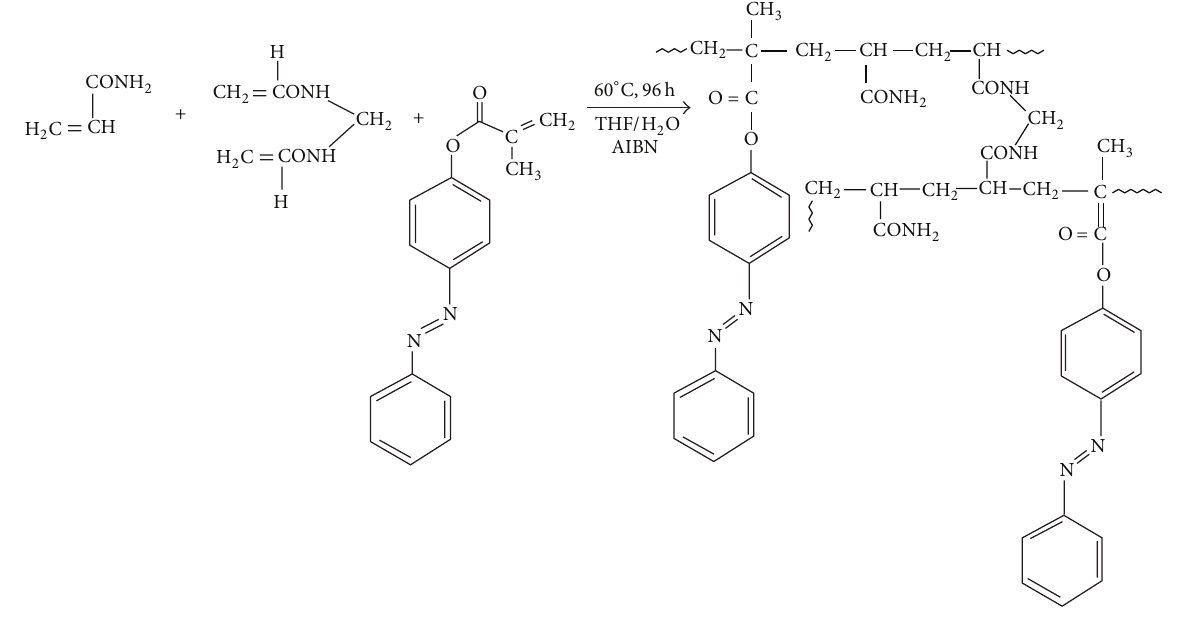
Figure 2: Reaction scheme for the synthesis of the polyacrylamide/azobenzene gel.